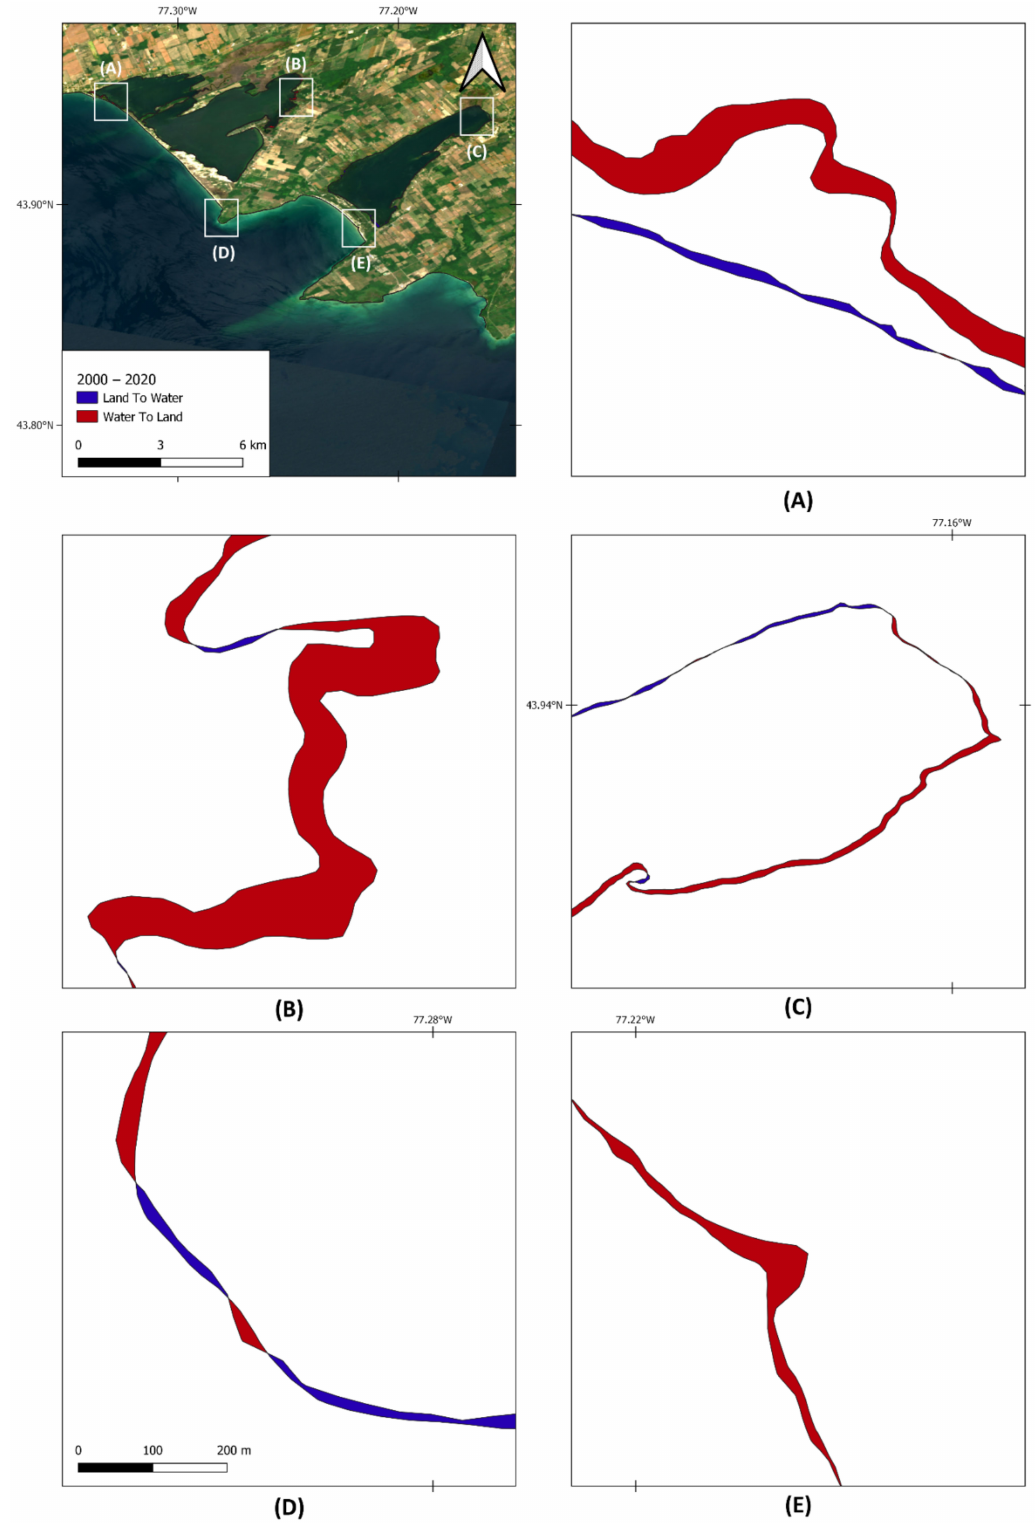
Figure 3. Coastal erosion and accretion from 2000 to 2020. Two parts are shown with more details from the adjacent Lake Ontario coasts ( D , E ), one part at the very end of the East Lake ( C ), one part at the eastern side of West Lake ( B ), and another zone at the narrow section of the baymouth dune between Lake Ontario and West Lake ( A